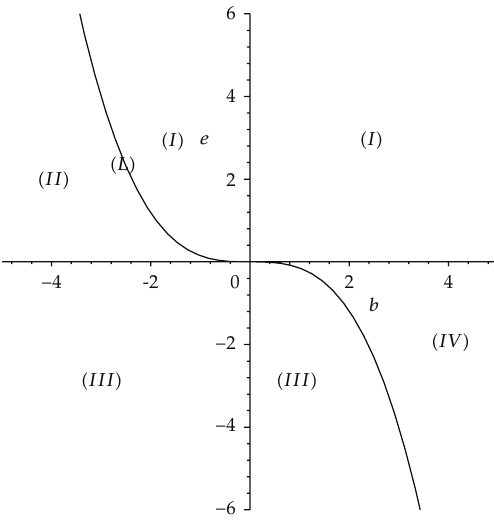
Figure 1: The bifurcation set of (cid:8) 1.6 (cid:9) in (cid:8) b,e (cid:9) - parameter plane.